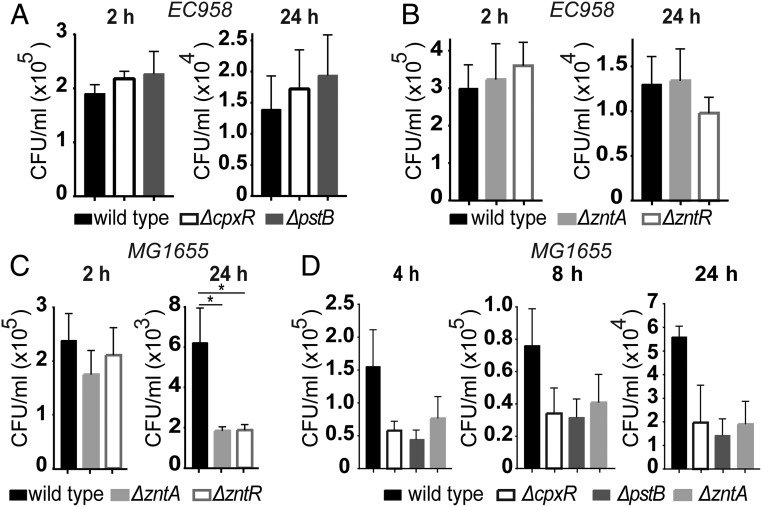
EC958 evades the zinc toxicity response of human macrophages. (A and B) HMDM were infected with wild-type EC958 or the indicated zinc-sensitive mutants (ΔcpxR, ΔpstB, ΔzntA, ΔzntR) for 1 h, followed by gentamicin exclusion. Cells were lysed and intracellular bacterial loads were determined at 2 and 24 hpi. Data (mean + SEM, n = 4–5) are combined from four (A) or five (B) experiments. (C) HMDM were infected, as above, with wild-type MG1655 or corresponding zntA and zntR mutant strains. Data (mean + SEM, n = 5) are from five experiments (*P < 0.05, one-way ANOVA, with Dunnett’s multiple comparisons test). Assays for B and C were performed in parallel within the same experiments to enable direct comparisons between EC958 and MG1655. (D) HMDM were infected, as above, with wild-type MG1655, alongside ΔcpxR, ΔpstB, and ΔzntA MG1655 mutants. Cells were lysed and intracellular bacterial loads were determined at 4, 8, and 24 hpi. Data (mean + SEM, n = 3) are combined from three independent experiments.